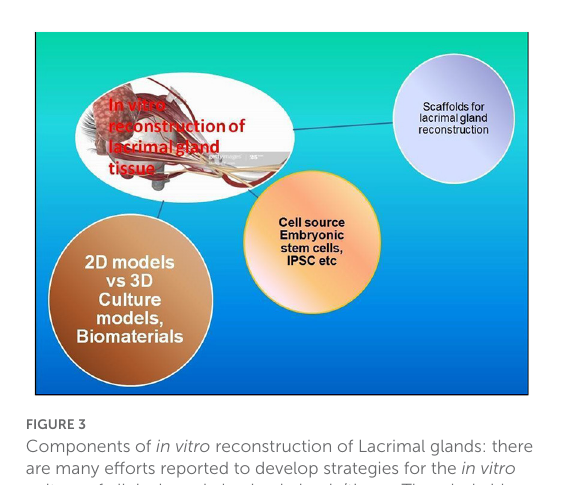
FIGURE3 Components of in vitro reconstruction of Lacrimal glands: there are many efforts reported to develop strategies for the in vitro culture of clinical-grade lacrimal glands/tissue. The whole idea revolves around (1) Cell sources and Types; Adult stem cells, ESCs, IPSCs, or MSCs; (2) Biomaterials and their suitability for tissue reconstruction assessment through 2D/3D in vitro culture models; (3) Scaffolds architecture, fabrications and culture associated biochemical, physical and functional parameter